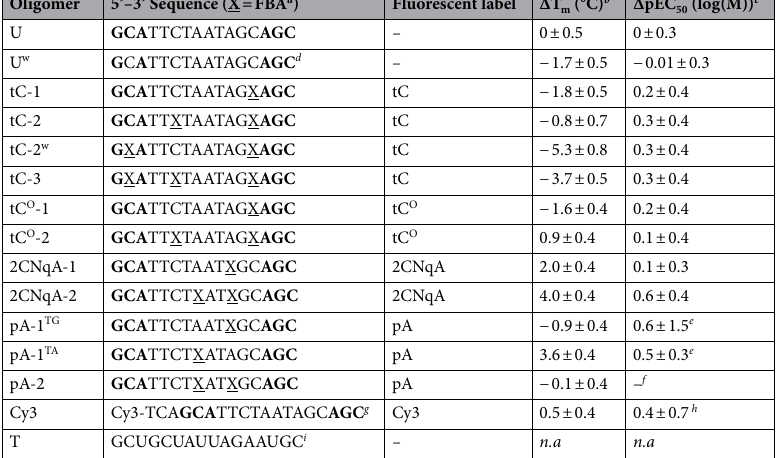
Figs. S22–S23 and Table S4 for dose–response data; unit for EC 50 : M), and we found that tC modifications barely affect the gapmer activity (ΔpEC 50 = 0.2–0.3), with no apparent differences between tCs positioned in the wings and gap of the sequence.